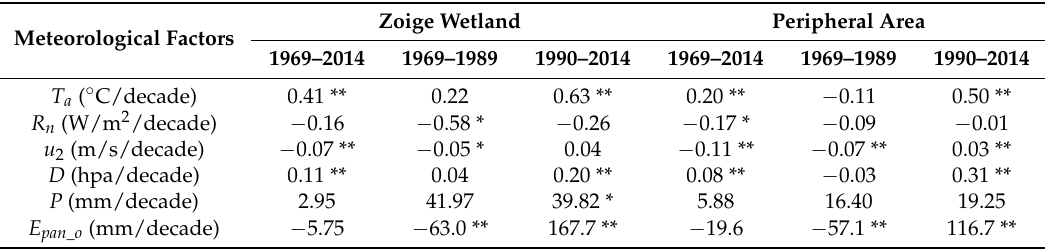
Table 3. The annual trends of the main meteorological factors in Zoige wetland and its peripheral